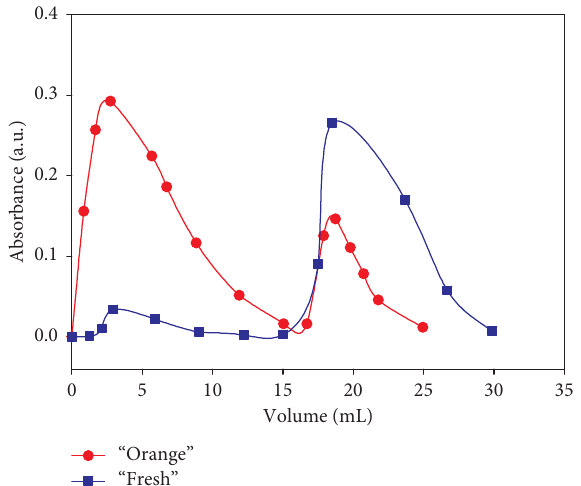
2 PO 4 (pH 3) containing 2.5%